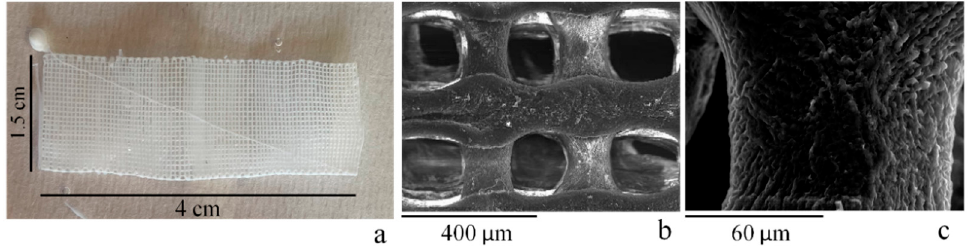
Figure 3. Chitosan scaffold (CS): ( a ) Picture; ( b ) SEM image (150×); ( c ) SEM image of a filament (1000×). (1000 ×